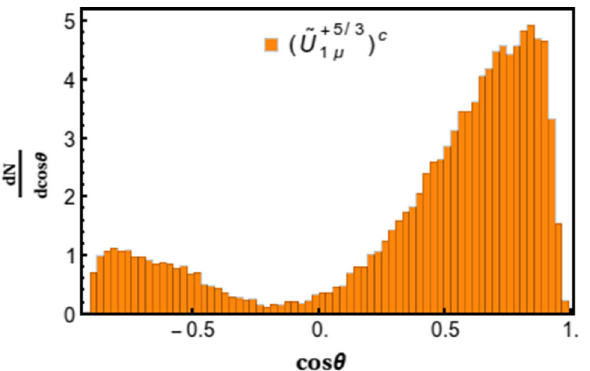
Fig. 10 Angular distribution for the associated production of the reconstructed 70 GeV vector singlet leptoquark (cid:8) U c GeV and L int = 100 fb − 1 at the rest frame of interaction 5.4 Vector singlet